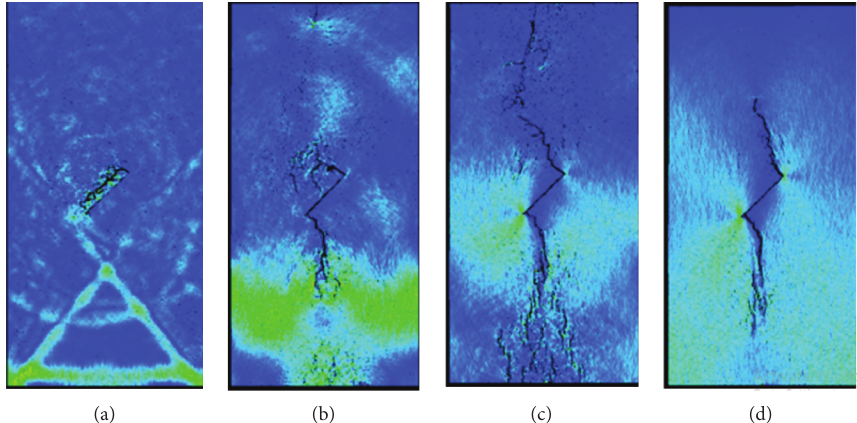
Figure 10: Failure patterns of rock specimen crack when subjected to stress wave from I to IV. (a) λ � 7.6mm. (b) λ � 37.98mm. (c) λ � 75.96mm. (d) λ � 189.9mm.